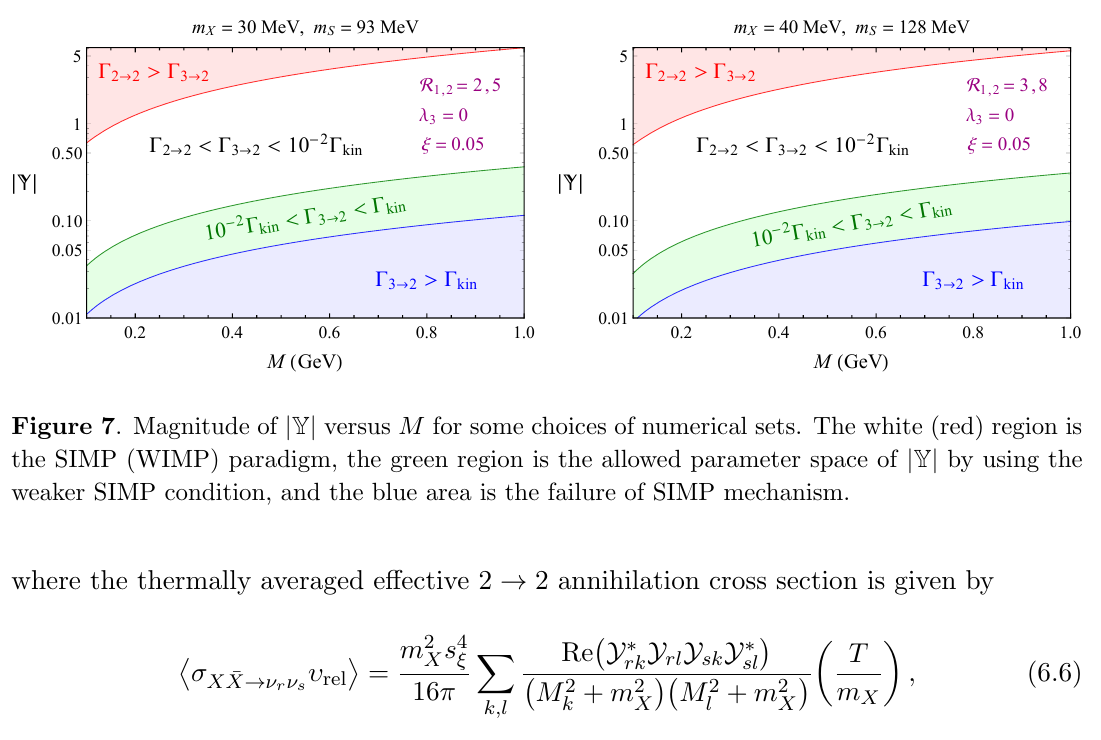
Figure 6 . (a) Feynman diagrams of the elastic scattering between X and the SM neutrinos. (b) Feynman diagrams for the 2 ! 2 annihilation process of a DM pair into a pair of the SM neutrino.